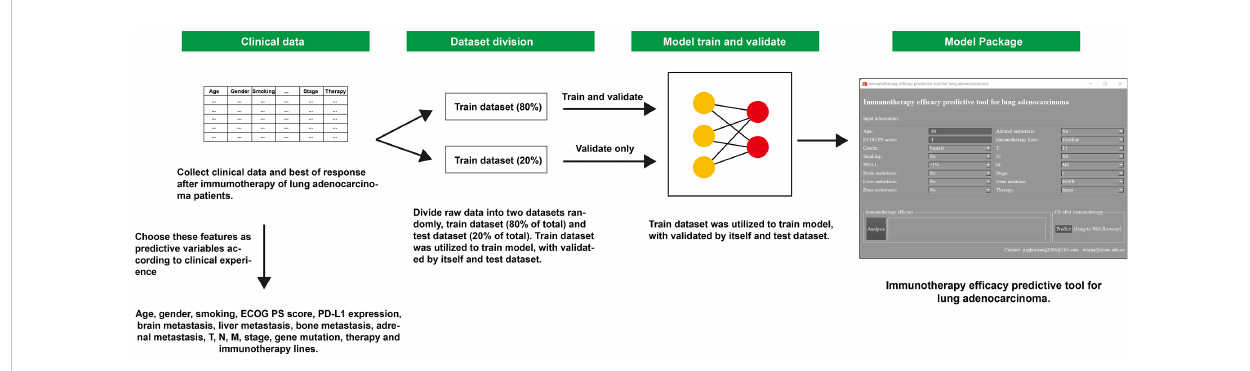
FIGURE 1 Work fl ow diagram of this study. ECOG, Eastern Cooperative Oncology Group; PS score, performance status score; PD-L1, programmed cell death ligand 1; OS, overall